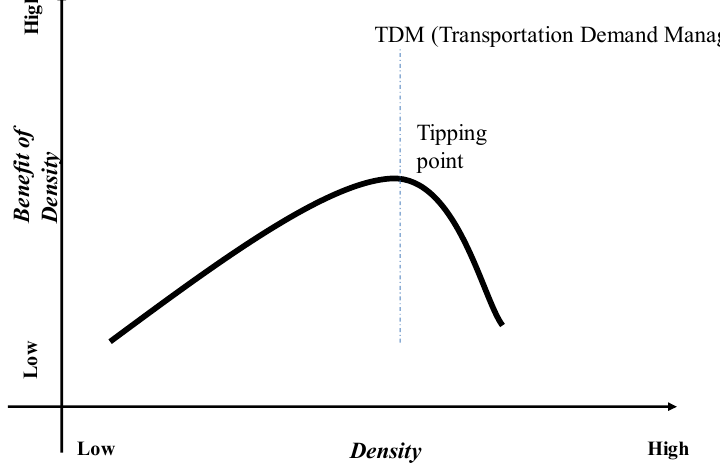
Figure 17. Density “tipping point.” After a certain point, benefits of density decrease exponentially